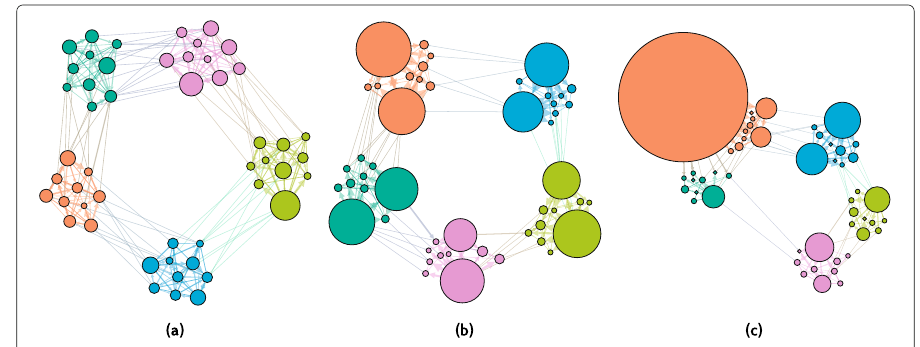
Fig. 3 Realisations from a block-constrained configuration model obtained by fixing the block-matrix B and varying the out-degree distribution. Each realisation is obtained from a BCCM with N = 50 vertices and m = 500 directed edges. The vertices are separated into 5 equally sized blocks and the block-matrix B is given by Eq. 10. On left side, a is a realisation from a BCCM where the degree distributions are uniform. It corresponds to a realisation from a standard SBM. In the center, b is a realisation obtained by drawing the out-degree distribution of the vertices in each block from a power-law distribution with parameter α = 1.8. On the right side, c is a realisation obtained by drawing the out-degree distribution of all vertices from the same power-law. All graphs are visualised using the force-atlas2 layout with weighted edges.